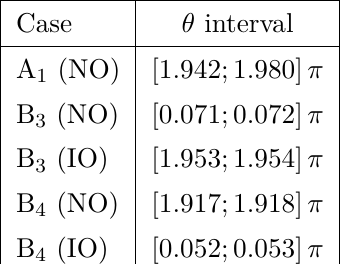
Table 3 . Intervals for the SCPV phase θ obtained by fixing c M ν to its best-fit value and varying R in the range [0 , 1] using eq. (3.7), for cases A colour code as in figure 3 and 4), and for NO (upper plots) and IO (lower plots)